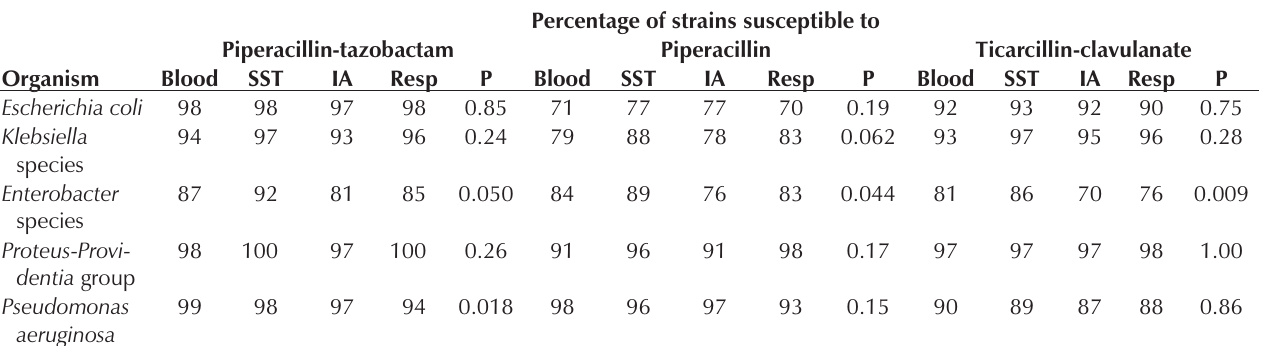
Comparative activity of piperacillin-tazobactam and other parenterally administered antibiotics against aerobic Gram-negative bacilli isolated from different body sites Percentage of strains susceptible